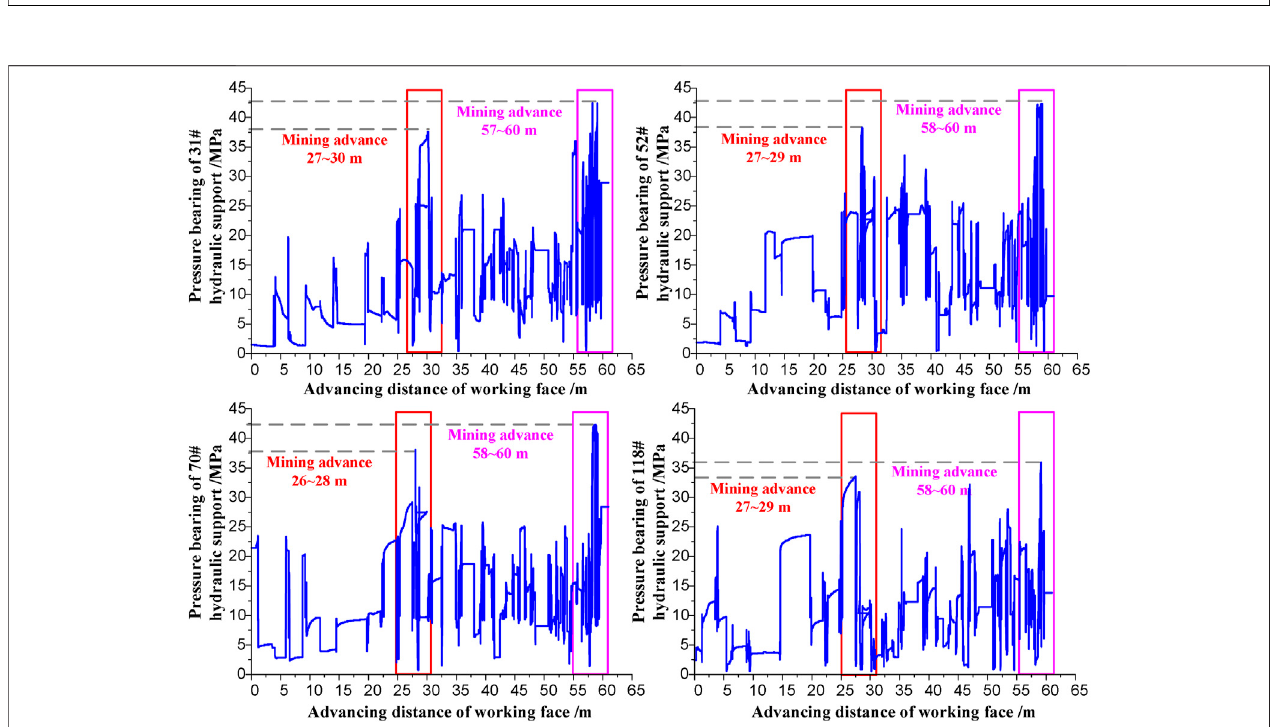
FIGURE 12 | Pressure monitoring of the working face hydraulic support (starting from the coal wall of the cut roadway).